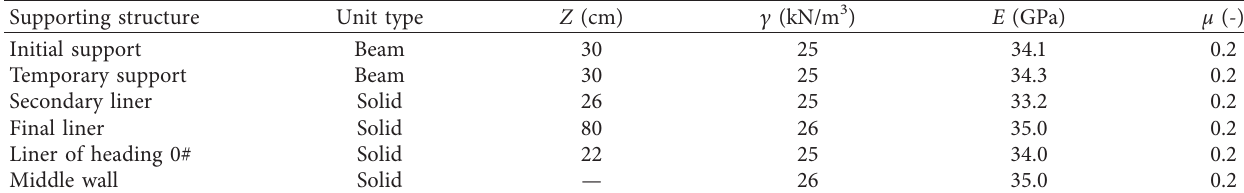
Table 2: Material parameters of the supporting structure.